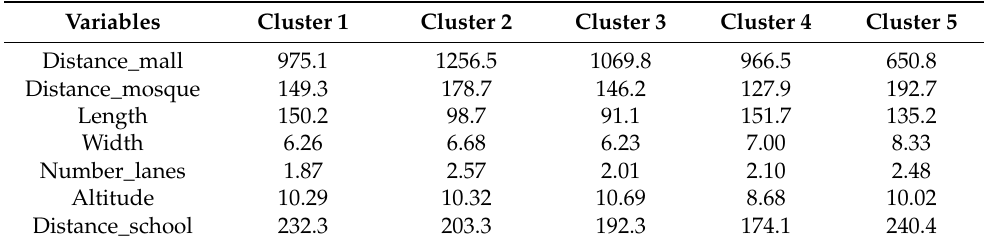
Table 6. Characteristics of WSR